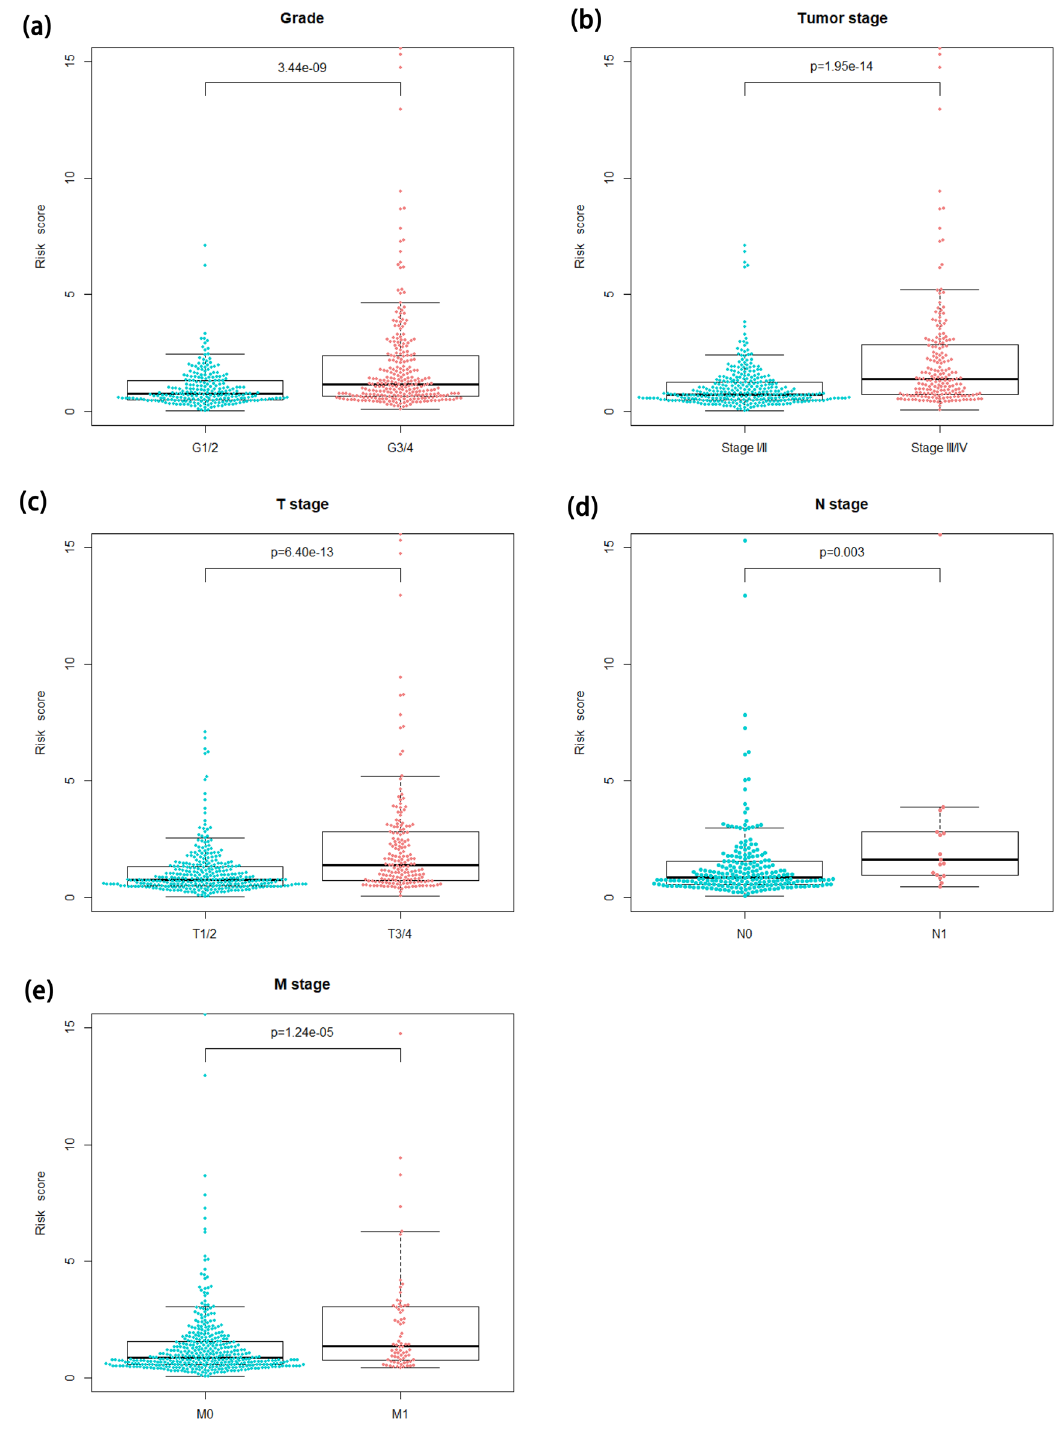
Figure 5. The correlation analysis of FLPS and clinicopathologic characteristics. ( a ) Grade (P = 3.44e−09). ( b ) Tumor stage (P = 1.95e−14). ( c ) T stage (P = 6.40e−13). ( d ) N stage (P = 0.003). ( e ) M stage (P =